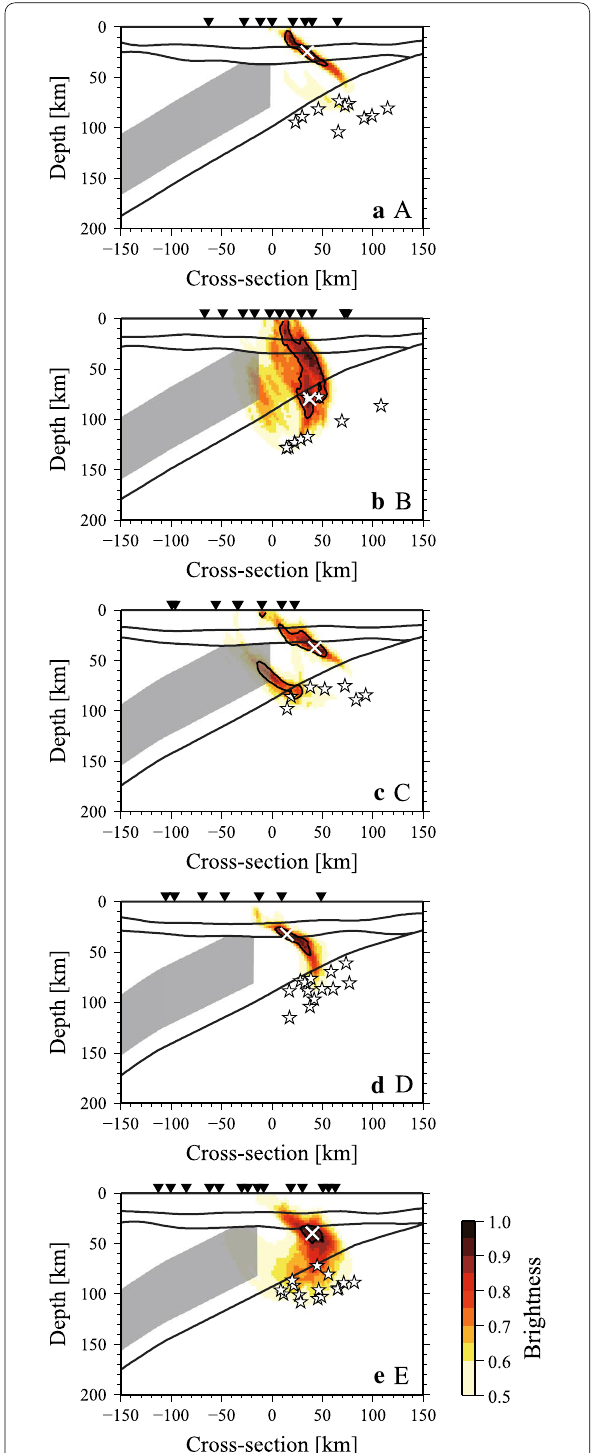
Fig. 7 Estimated locations of passing points from forearc intraslab earthquakes. Symbols are explained in the caption of Fig. 5